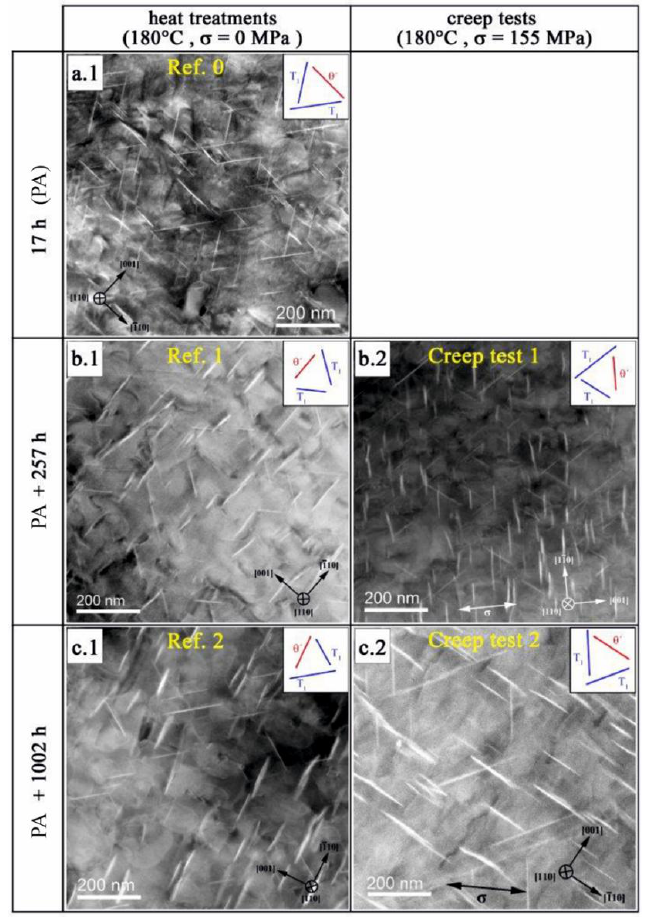
Figure 6. DF-STEM images of the microstructure as a function of aging treatment: ( a.1 ) PA-state; ( b.1 , c.1 ) after aging without load; and ( b.2 , c.2 ) after loading under applied load (creep).